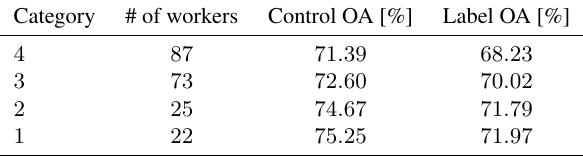
Table 1. Allocation of crowdworkers to quality categories and corresponding Control OA (binary) and Label OA